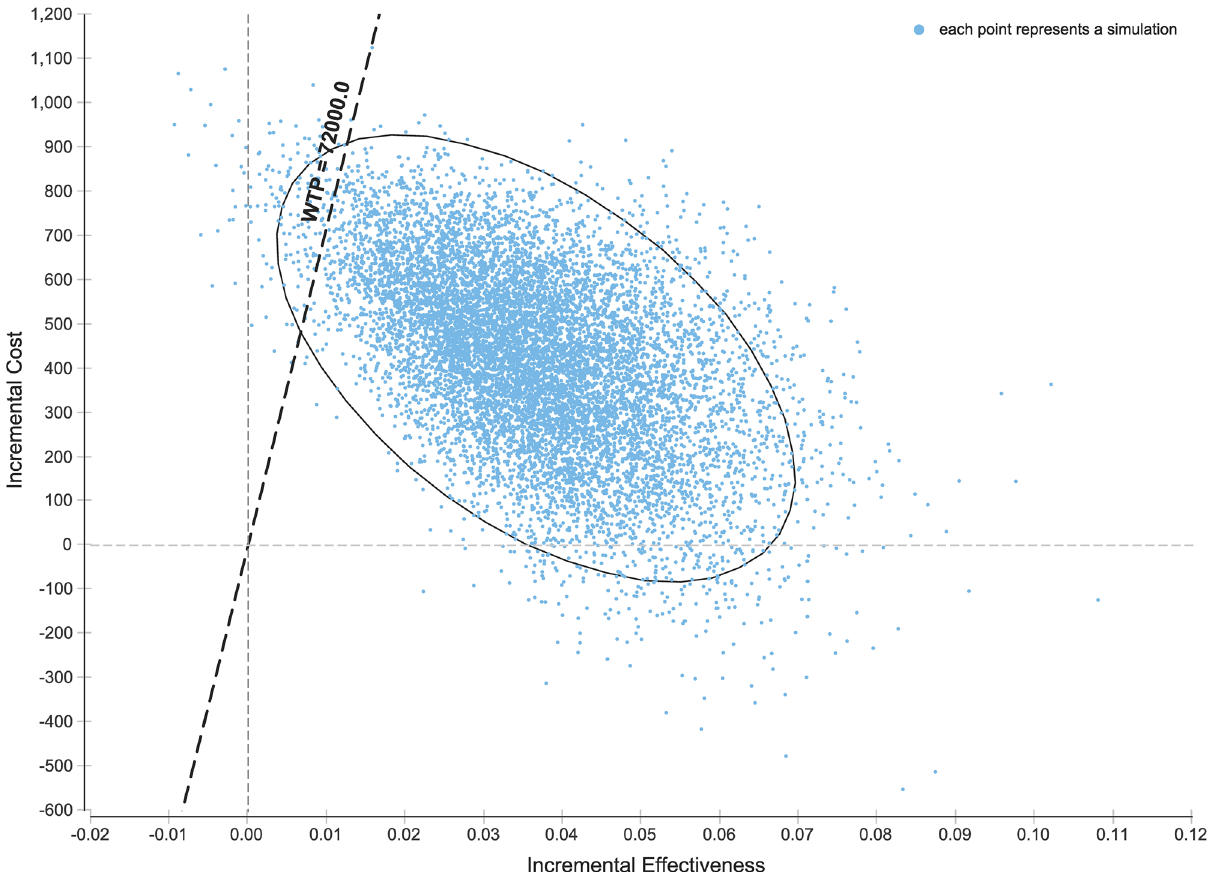
Figure 2. Incremental cost-effectiveness scatterplot of the result of the probabilistic sensitivity analysis. The dashed line represents the willingness-to-pay threshold of CNY 105,000 per QALY. The white square represents the base-case (0.031 QALYs gained at an incremental cost of CNY 420.13). CNY, Chinese Yuan Renminbi; QALYs, quality adjusted life years; WTP,